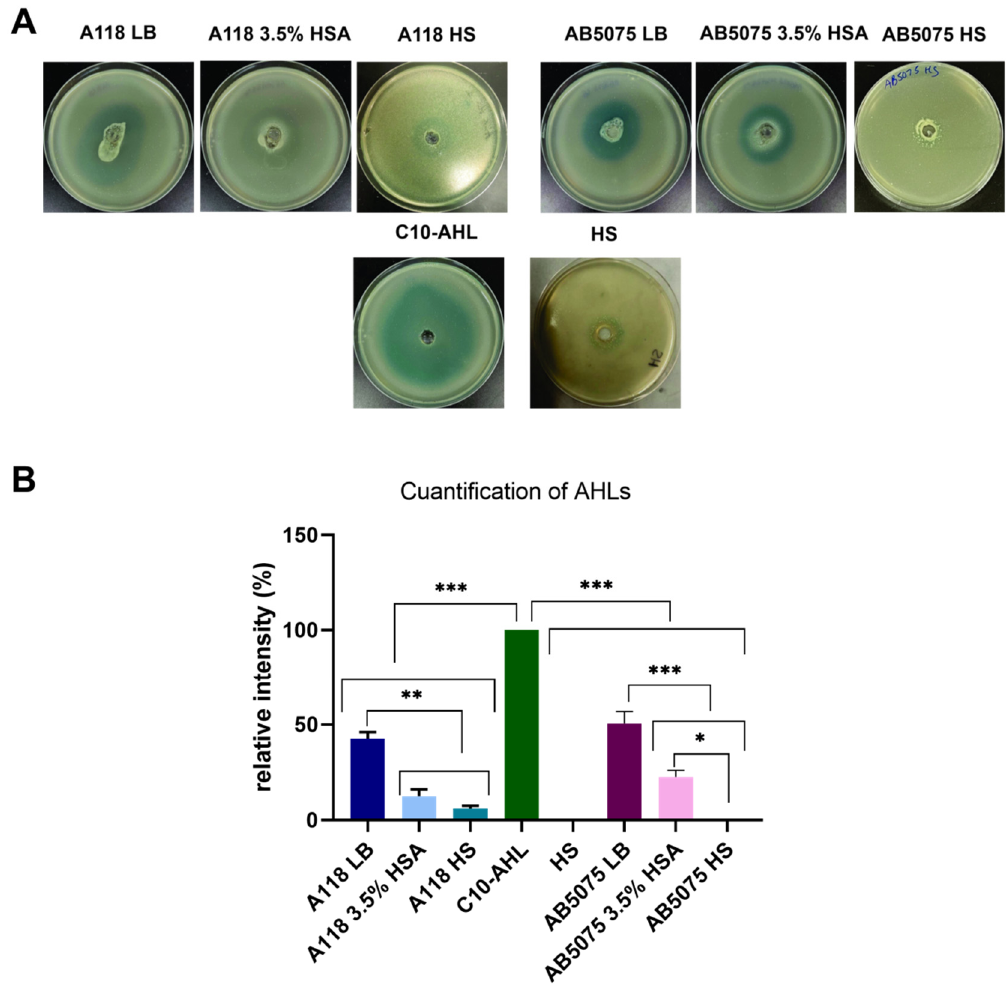
Figure 7. Effect of human serum albumin (HSA) and pooled normal human serum (HS) on quorum sensing in A. baumannii . ( A ) N-Acyl Homoserine Lactone (AHL) detection in A. baumannii A118 and AB5075 supernatants of bacterial cultured in LB, LB supplemented with 3.5% HSA, or HS, using Agrobacterium tumefaciens as reported strain. The presence of AHL was determined by the development of the blue color. ( B ) Quantification of 5,5 ′ -dibromo-4,4 ′ -dichloro-indigo was estimated as the percentage relative to C10-AHL standard, measured with ImageJ (NIH). As negative control, HS was used. The mean ± SD is informed. Statistical significance ( p < 0.05) was determined by ANOVA followed by Tukey’s multiple-comparison test. one asterisks: * p < 0.05; two asterisks: ** p < 0.01 and three asterisks: *** p < 0.001.